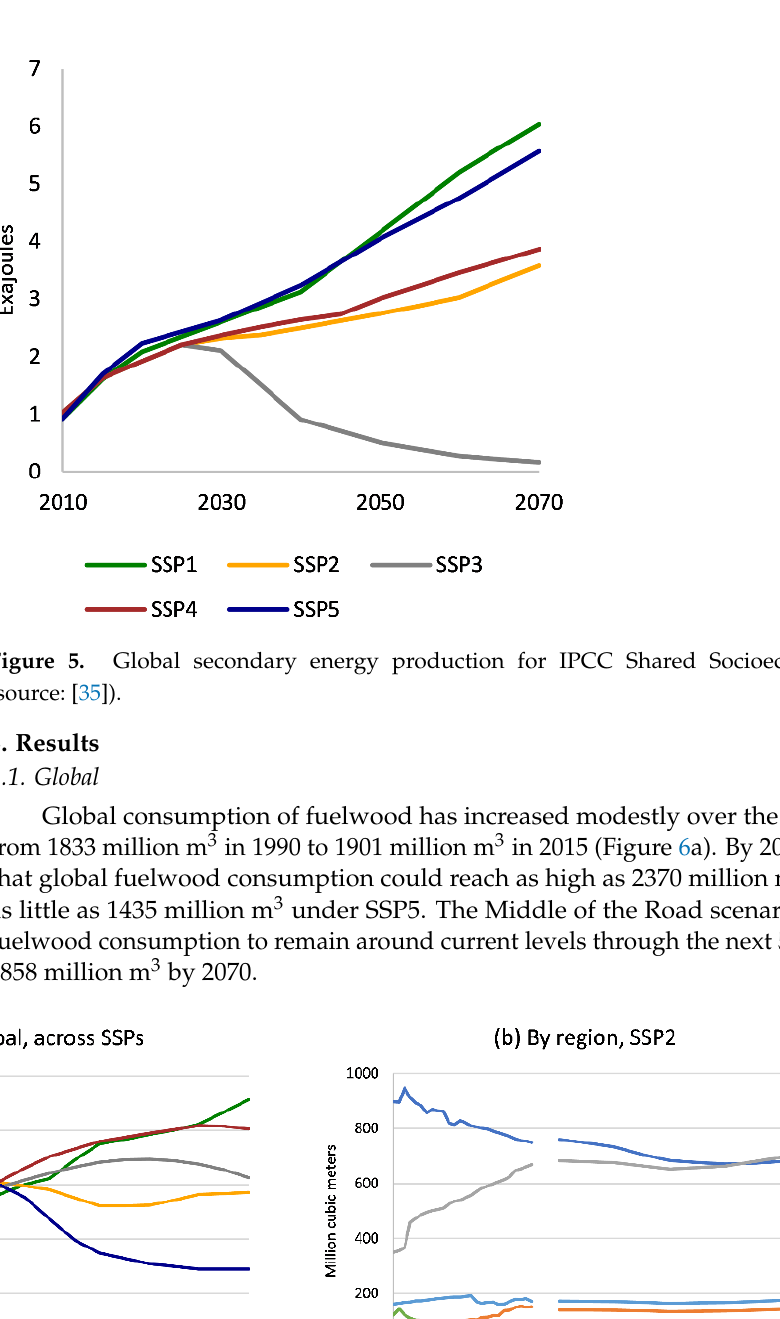
Figure 4. Global primary energy production for IPCC Shared Socioeconomic Pathways (source: [35]).